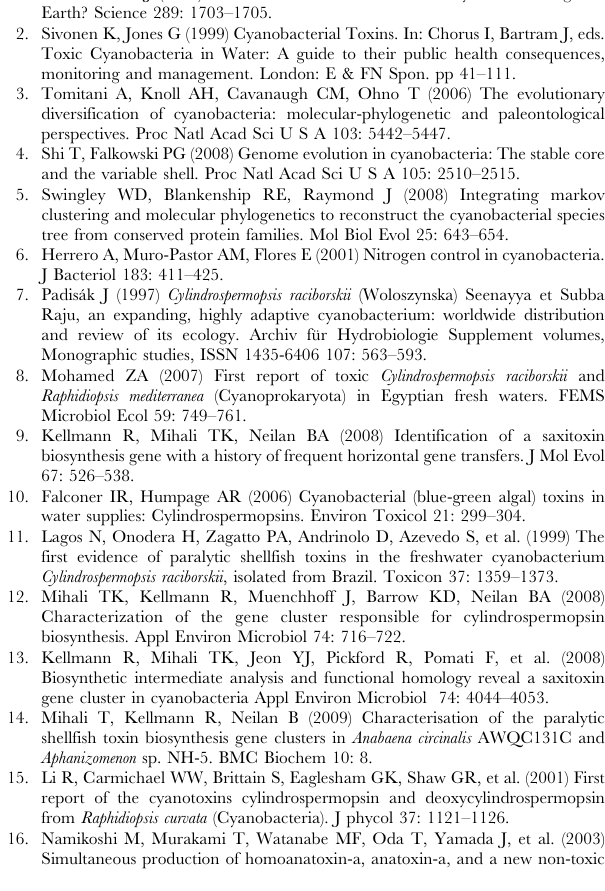
Table S1 List of the unique CDS of CS-505 and D9 and their classification into the different COG categories.